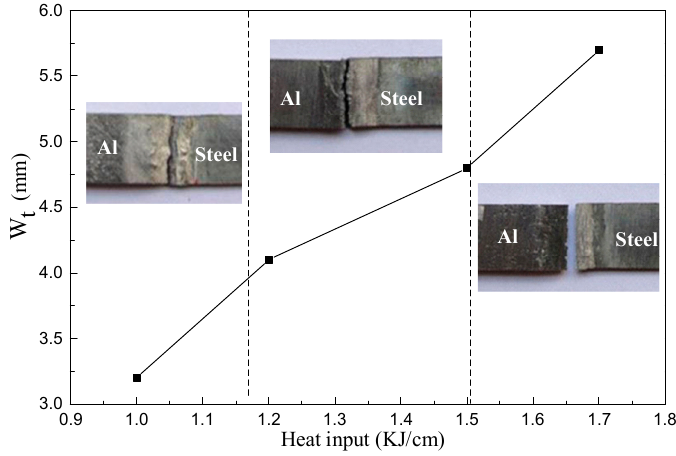
Figure 13. Fracture modes of the weld joints in different welding heat input.